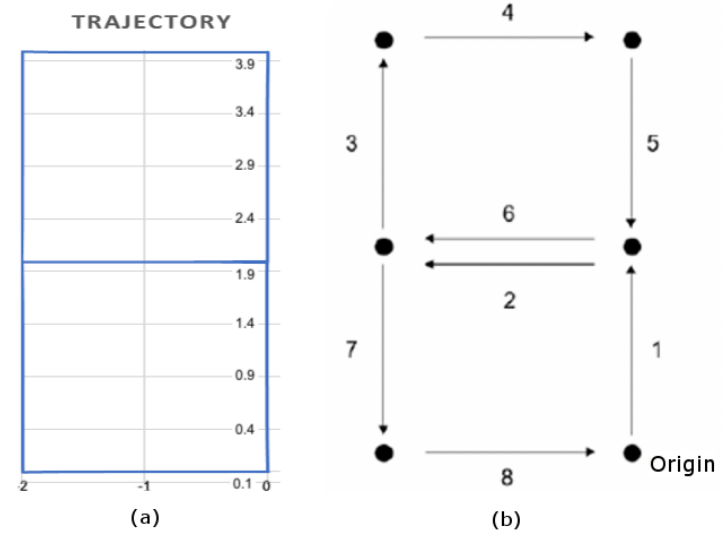
Figure 2. Robot operation. ( a ) Trajectory calculated from internal odometry and ( b ) Sequence of